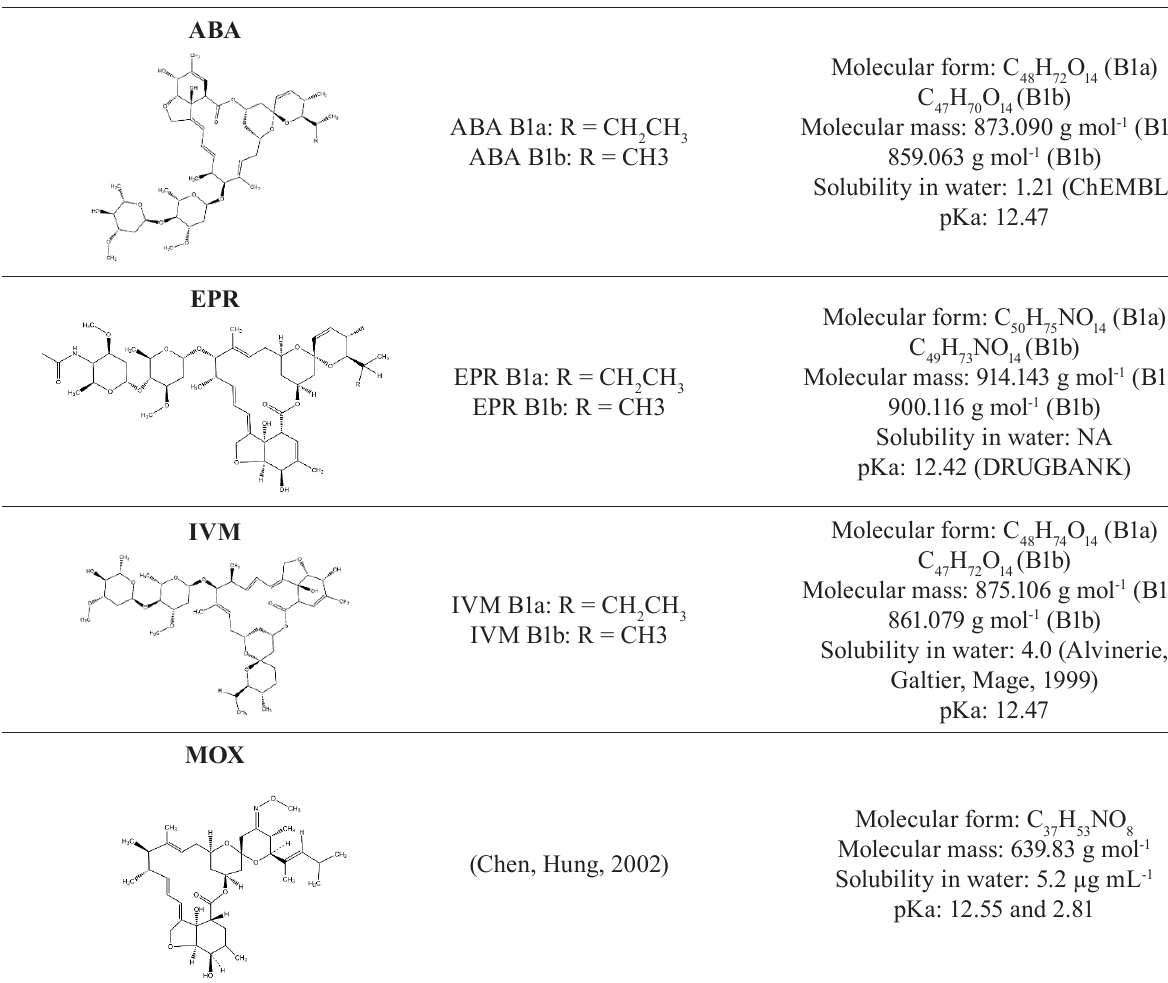
TABLE I - A ntiparasitics structures and properties (Chemicalize) Antiparasitics